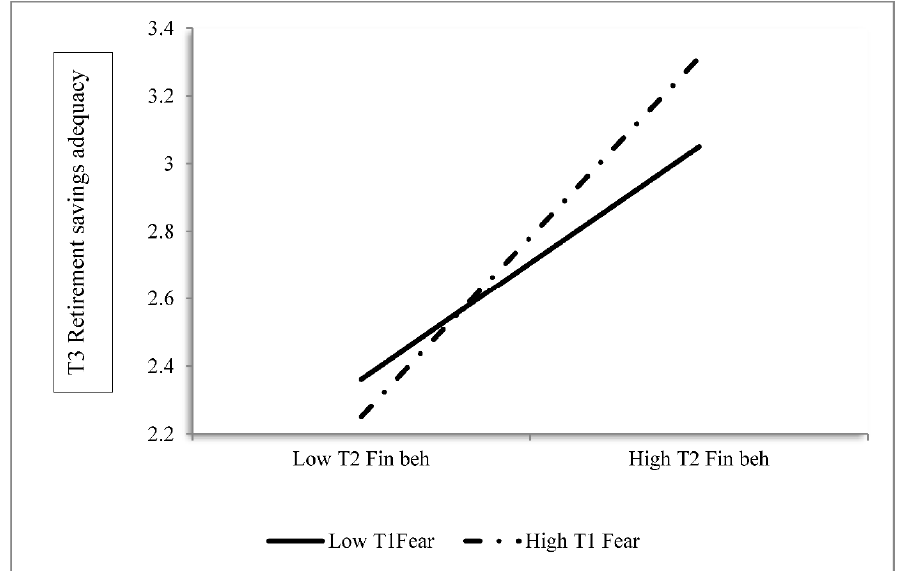
Figure 3. Interaction of T2 Financial Behavior and T1 DA in predicting T3 Retirement Savings Adequacy.